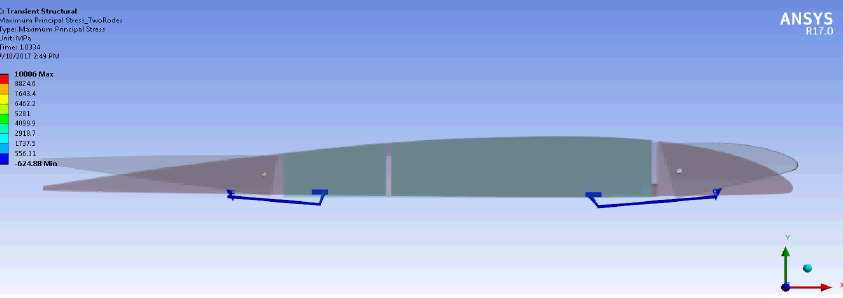
Figure 9. FEA results on the actuation system.